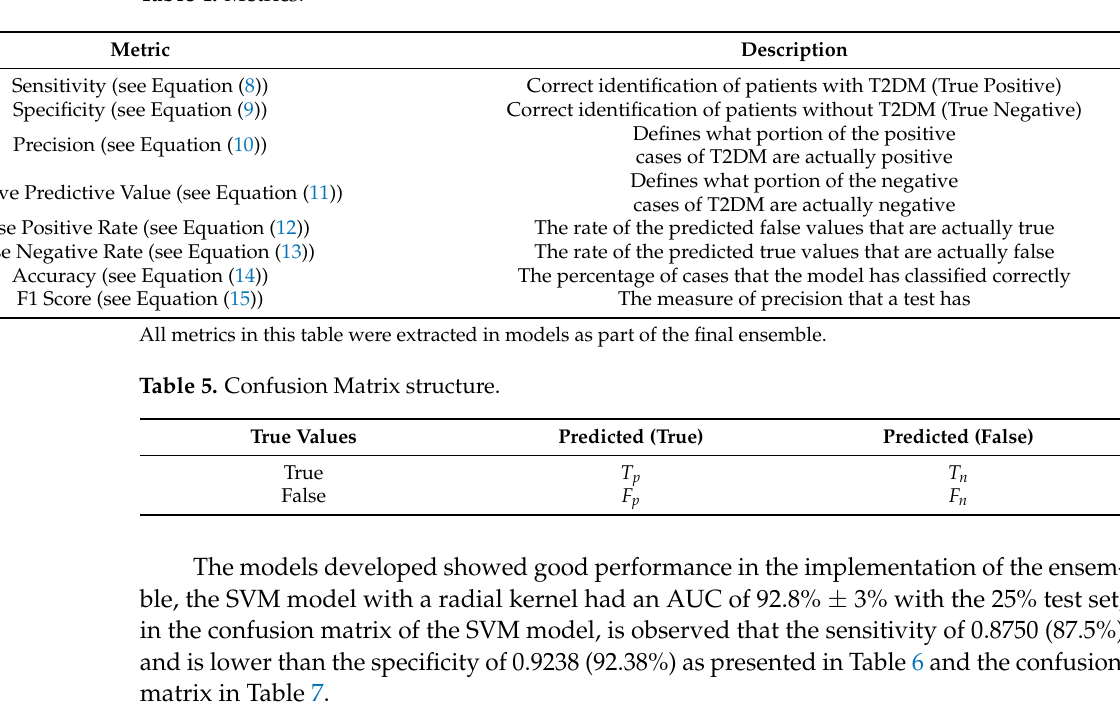
Table 4. Metrics.